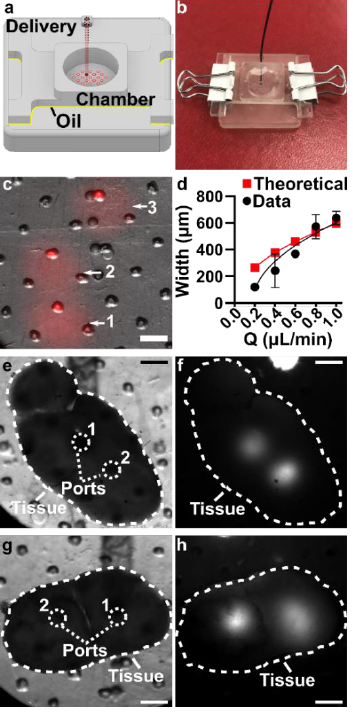
Figure 4. Optimization of the fabrication strategy for a 3D printed chamber with a microporous bottom. Three fabrication strategies were tested: ( a ) incorporating a mesh at the bottom of the de- vice by adhering it to the glass-covered base plate during printing, ( b ) directly printing ports, and ( c ) laser etching the ports after printing. ( d , e ) The optimized design of the chamber component shown as an AutoCAD inventor drawing and the 3D printed and laser-etched piece. Inset: Micro- graph of the ports etched into the chamber. Scale bar 0.5 mm.